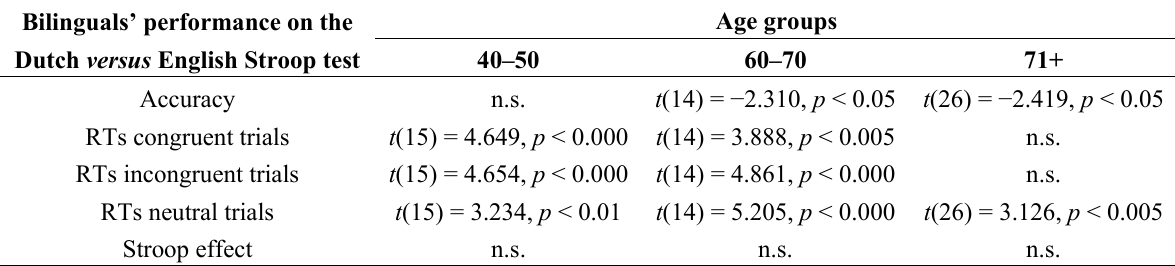
Table 6. Paired-samples t -test statistics for the Dutch versus English Stroop